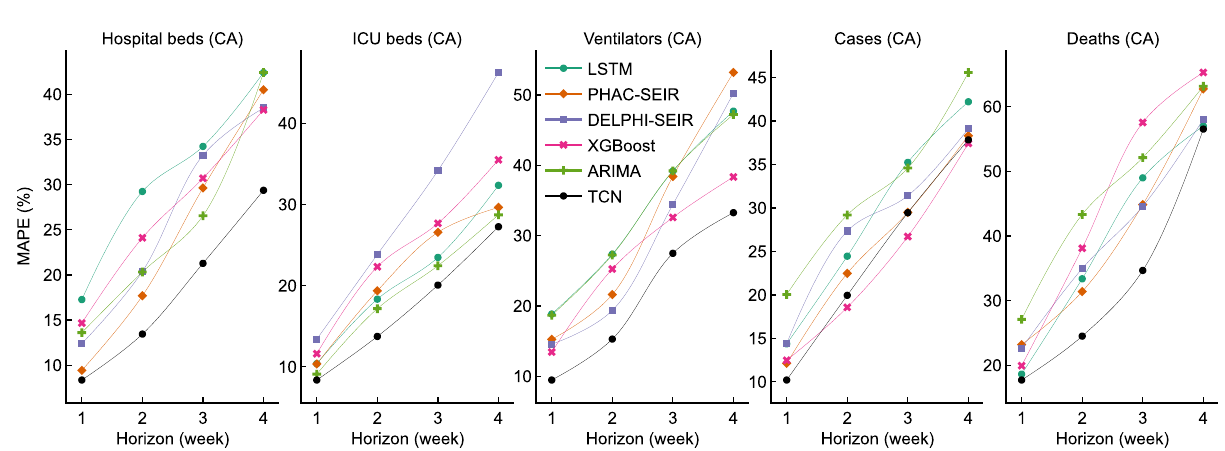
Figure 7. Models’ performance, in terms of MAPE (%) of the 1-,2-,3-,4-week forecasts in Canada